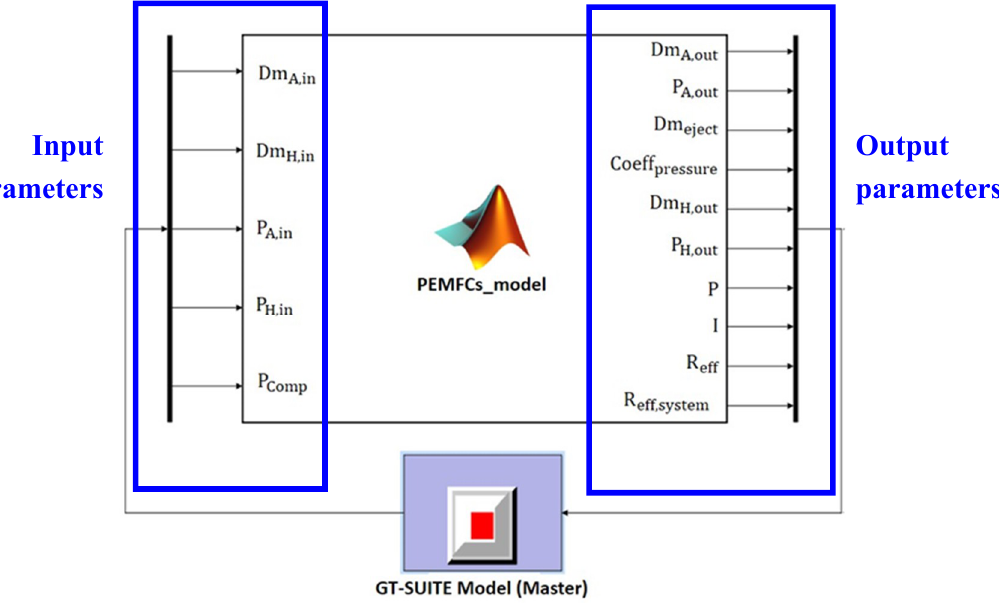
Figure 2. MATLAB/SIMULINK diagram using a Matlab function (PEMFCs_model) and a GT-SUITE master block.